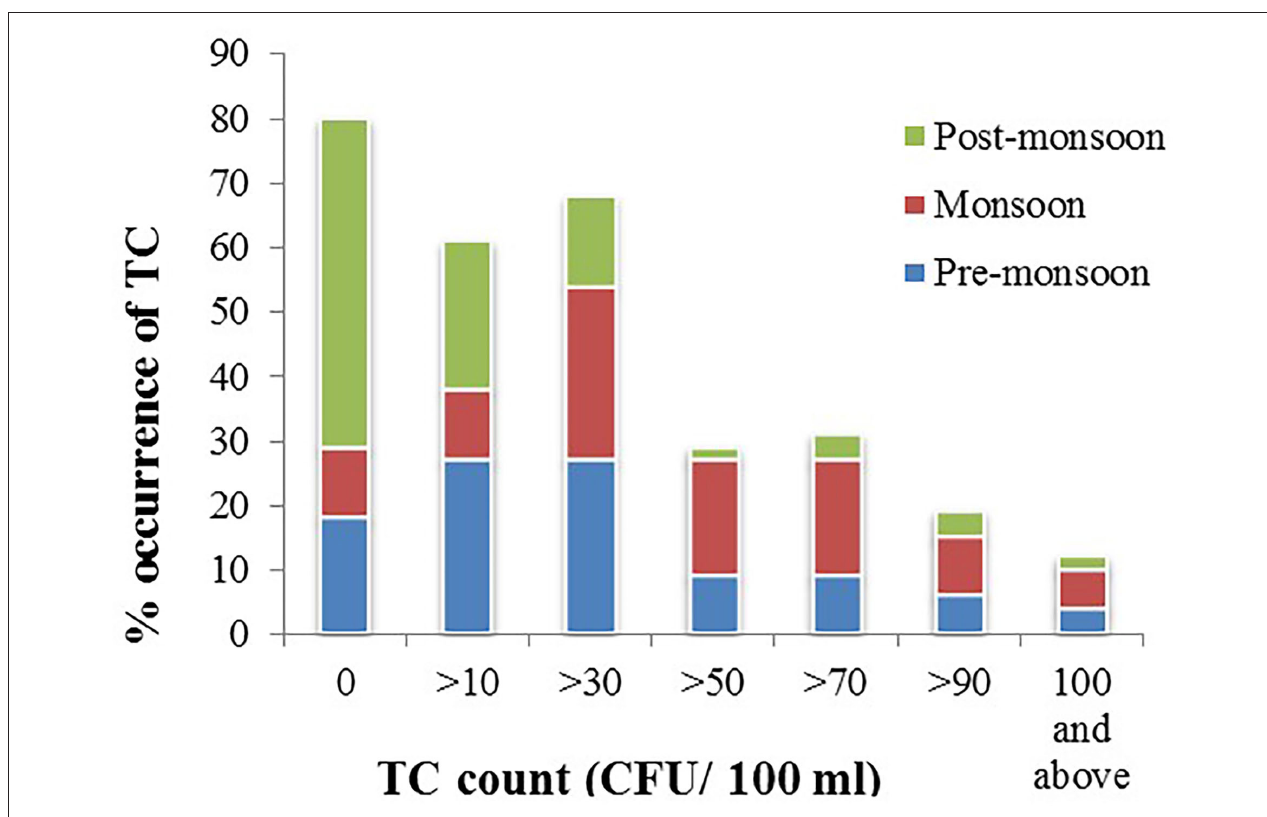
FIGURE 2 | Percent occurrence of total coliform (TC) in groundwater samples in pre-monsoon, monsoon, and post-monsoon